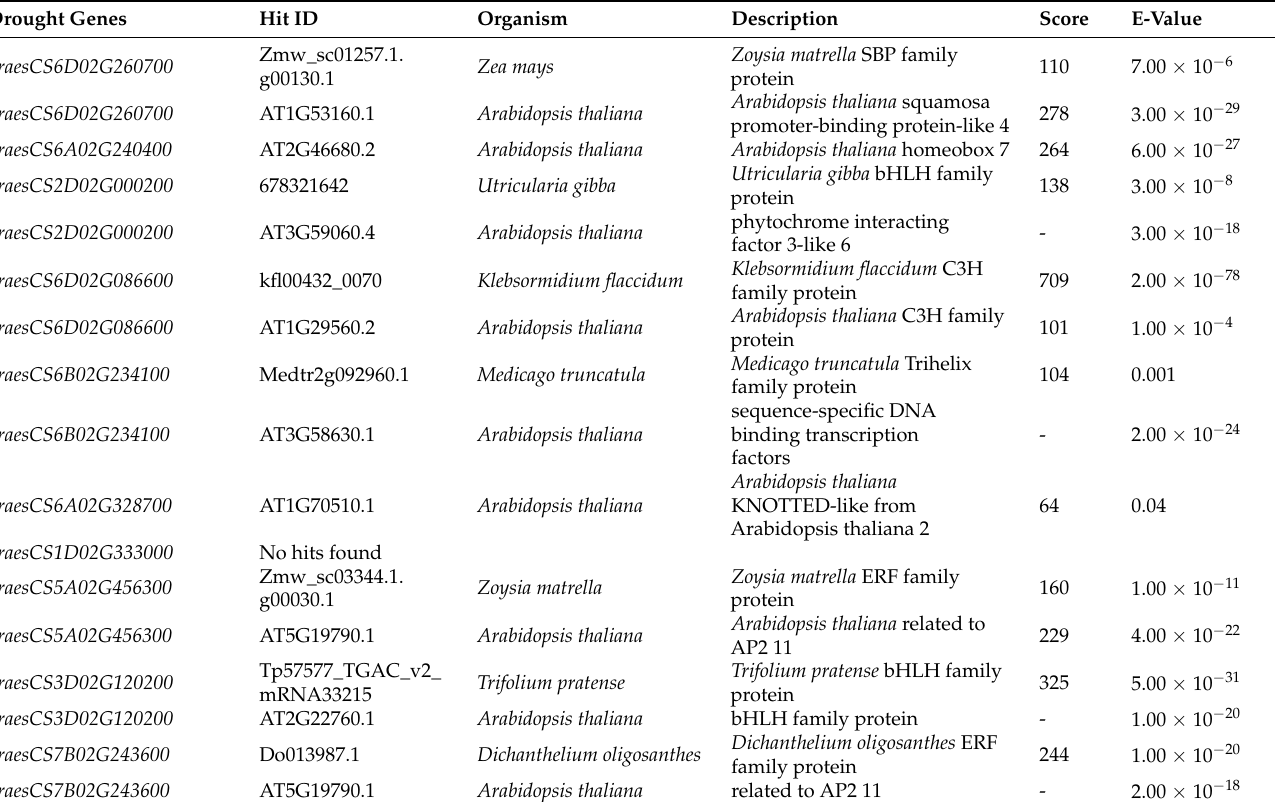
Table 4. Searching the homologs of SDGs in annotated genomes of Arabidopsis thaliana, Dichanthe- lium oligosanthes, Klebsormidium flaccidum, Medicago truncatula, Trifolium pratense, Utricularia gibba, Zea mays and Zoysia matrella.